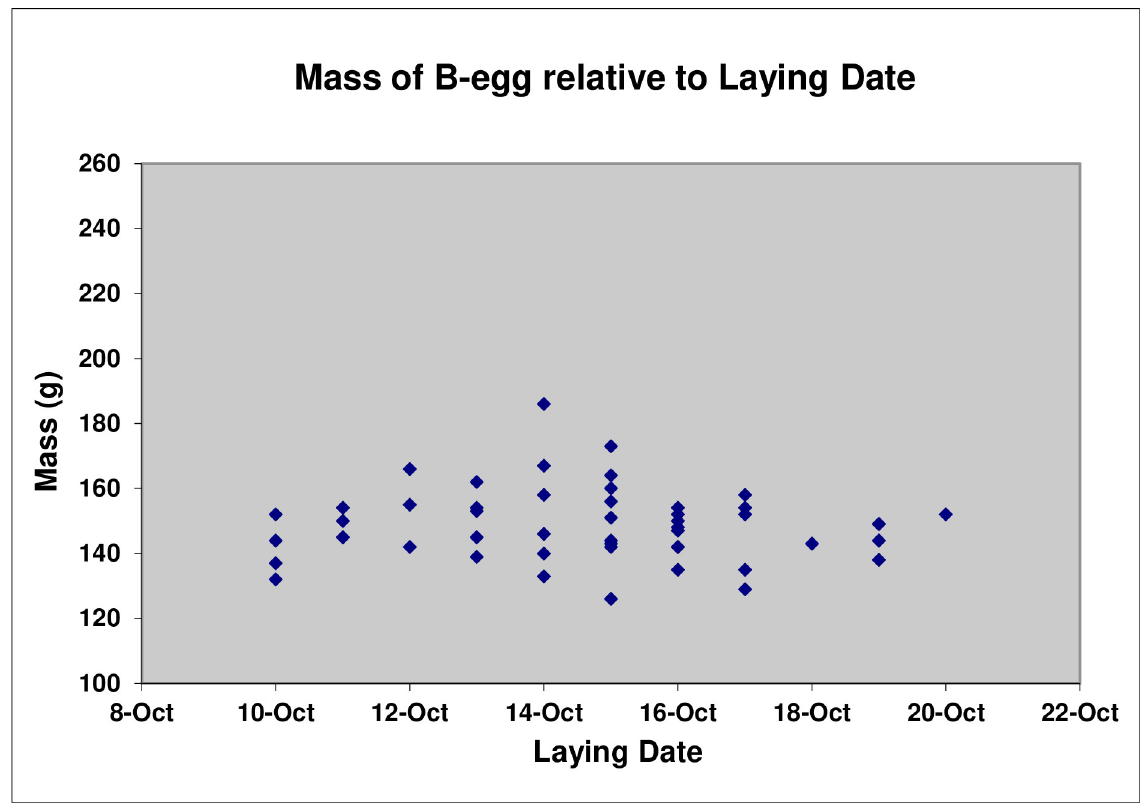
Fig 7. Mass of B-eggs relative to laying date (n =